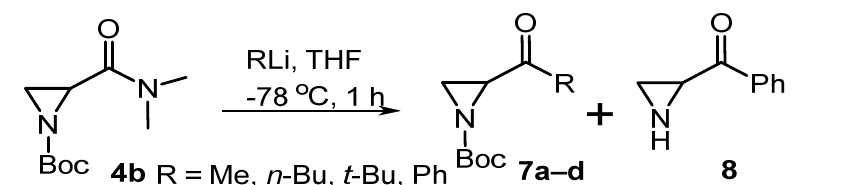
Table 4. Reaction conditions and yields of compounds 7a–d and 8 .